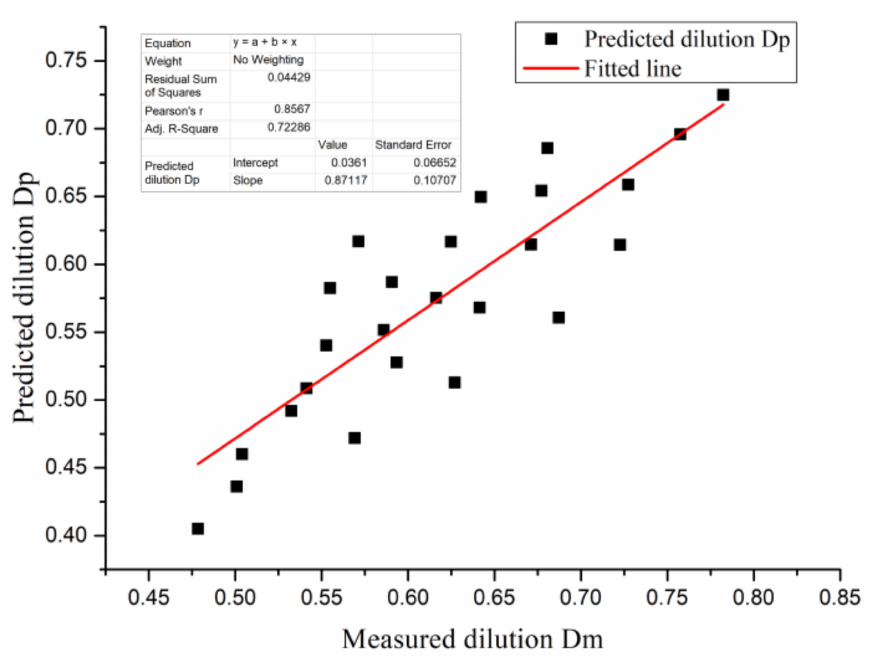
Figure 6. Comparison between the predicted dilution ratio and measured value using the EPRI- recommended base metal melting